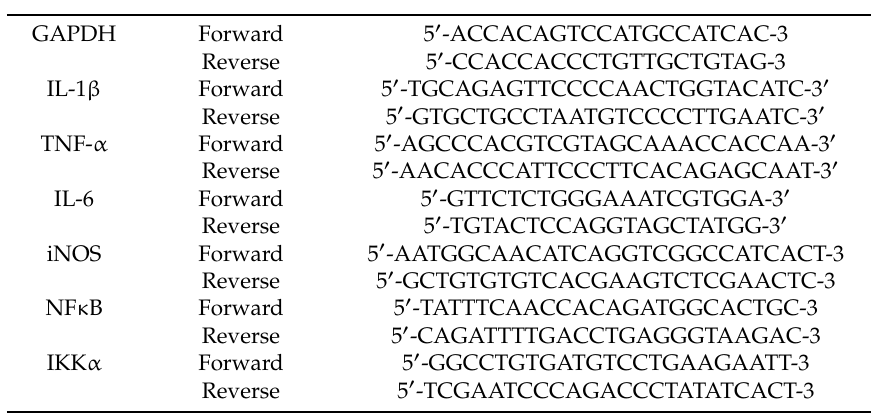
Table 3. List of